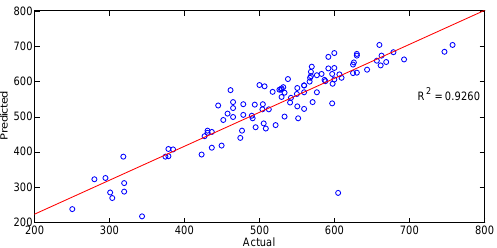
Figure 16. Correlation between actual and predicted NDVI values of 100 randomly selected pixels at t p =